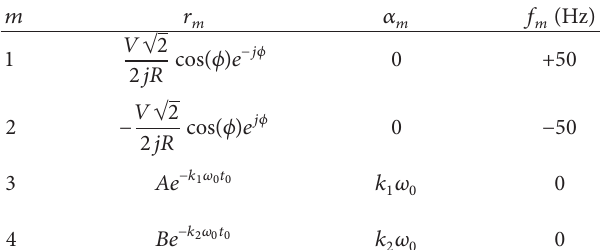
Table 4: The residues, attenuation factors, and frequencies of the series RLC